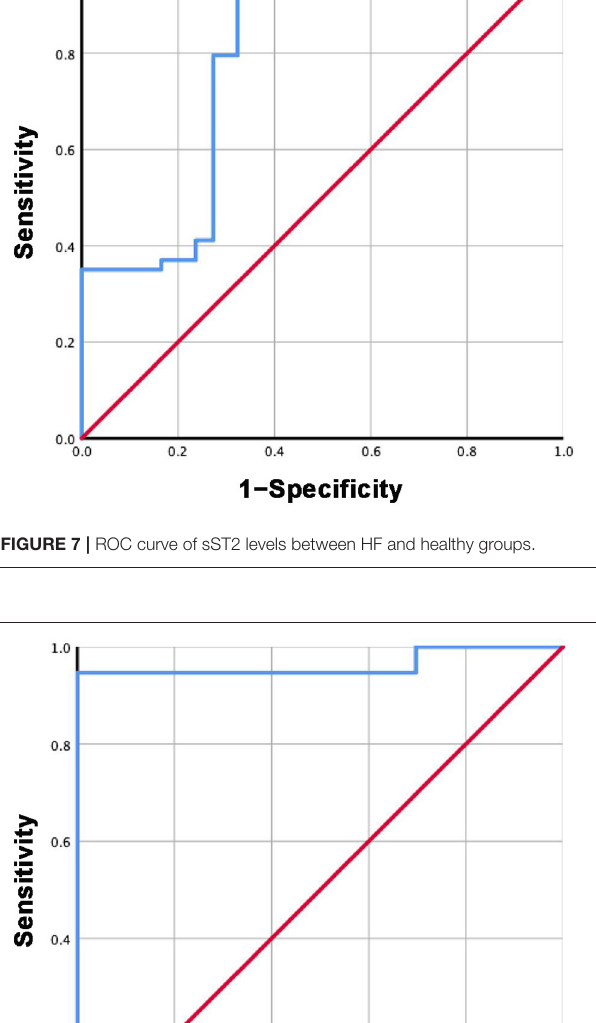
72 h, remodeling via myocyte hypertrophy and alterations in ventricular architecture begin to affect post-infarction repair (49). The studies investigating MI and IHD included in the meta-analysis reported that blood samples were taken as soon as possible when patients were sent to the emergency room. Thus, increased sST2 levels may not have been observed within the hyperacute or acute phase of